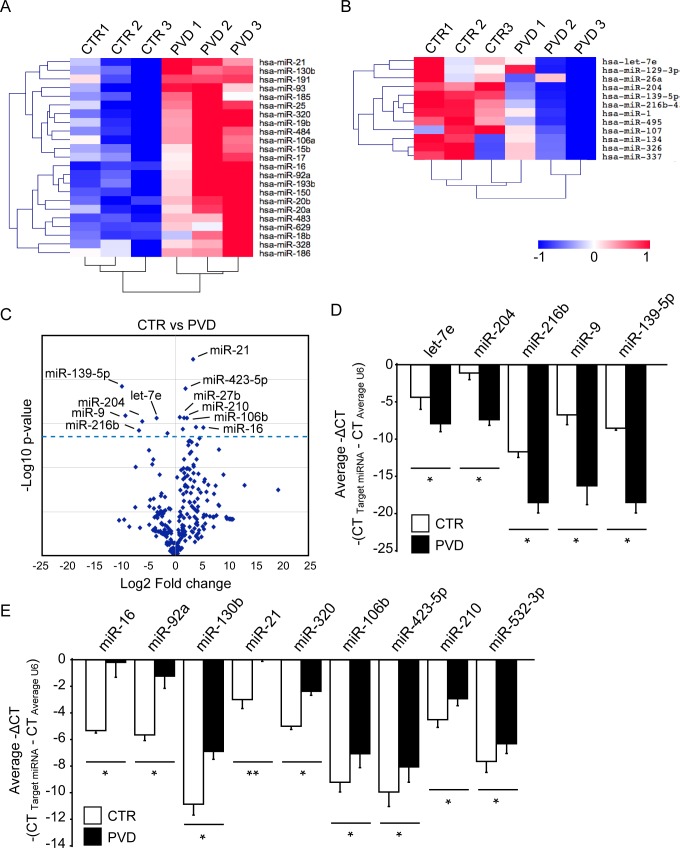
Comparison of expression levels of miRNAs in the PVD and MH samples.(A, B) Clustering analyses of the expression patterns of microRNAs (miRNAs) in the vitreous of PVD (n = 3) and control MH (n = 3) samples. Red indicates high expression and blue indicates low expression. (C) Volcano plot of real-time polymerase chain reaction (PCR)-based miRNA array data from the vitreous humor of PVD and control MH samples. Profiling for 377 miRNAs was performed on the vitreous humor of PVD (n = 3) and control MH (n = 3) samples. The y-axis depicts the negative log10 of p-values of the t-tests (the horizontal line corresponds to a p-value of 0.05; a higher value indicates greater significance), and the x-axis depicts the difference in expression between the two experimental groups as log2 fold changes. (D, E) Expression levels of miRNAs detected by real-time PCR-based miRNA arrays that were significantly different (p < 0.05) between PVD (n = 3) as compared with control MH (n = 3) samples. The average of ΔCt values of control MH samples (white bars) and proliferative vitreoretinal disease (PVD) samples (black bars) were calculated with standard deviations. To reverse the inverse relationship between ΔCt values and miRNA expression levels, ΔCt values were transferred into negative ΔCt values. The differences of ΔCt values between PVD and control MH samples are shown by relative expression levels of downregulated miRNAs (D) and upregulated miRNAs (E) in PVD. CTR; control, PVD; proliferative vitreoretinal disease; MH, macular hole. ** p < 0.01; *p < 0.05.